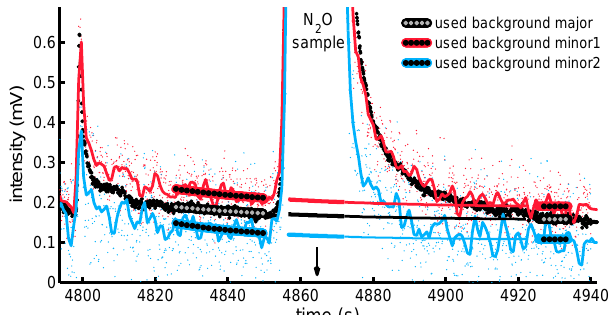
Figure 5. Zoom into the background region of the N 2 O sample peak (peak maximum indicated by the arrow). For clarity, the mi- nor1 and minor2 signals are plotted as a 1.5s moving average to show the faint trends. For the background correction, an exponen- tial fit is calculated using background data before and after the N 2 O peak (dotted intervals). The thick solid lines below the N 2 O peak indicate the subtracted background signals. Thin lines connect the background below the N 2 O peak with the background region after the peak to visually examine the quality of the fitting